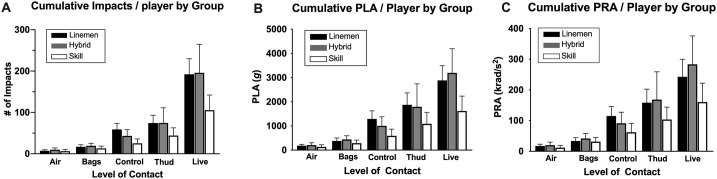
Group-dependent cumulative head impact exposure between levels-of-contact.All 3 groups shared similar incremental pattern in cumulative (A) head impact count, (B) peak linear acceleration, and (C) peak rotational acceleration per player, with live being the highest and air being the lowest. There was no group difference in the cumulative head impact frequency or magnitude. Data are presented as mean ± SD. Please refer to S2 Table for median (IQR) values of head impact kinematics.